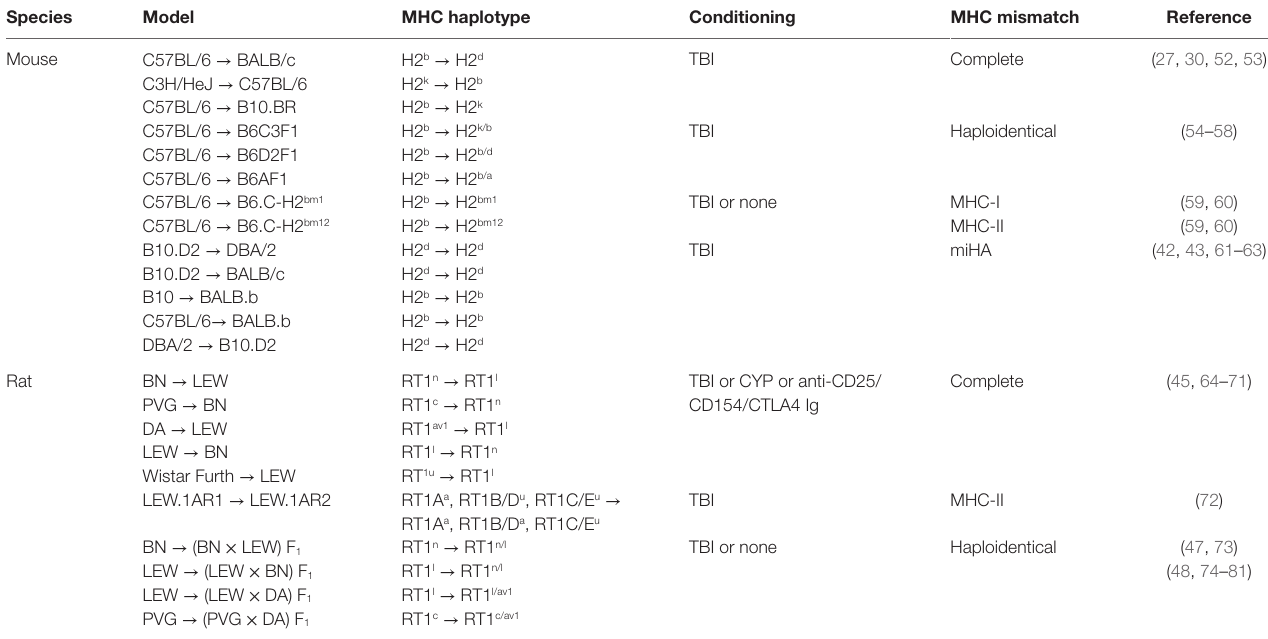
TABLe 1 | Overview of rodent models for acute GvHD.